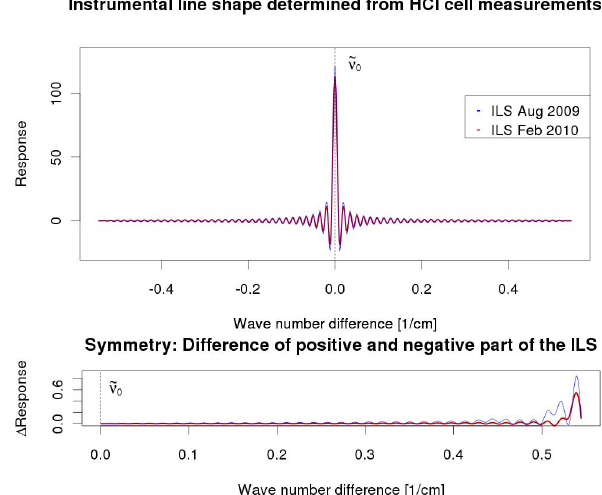
Fig. 10. Comparison of the instrument line shape of the Jena Bruker IFS125HR in August 2009 and February 2010. The x-axes repre- sent the wavenumber difference relative to the center peak position ˜ ν 0 . The lower part of this Figure shows the difference between the positive and negative part of the ILS as a measure of symmetry.